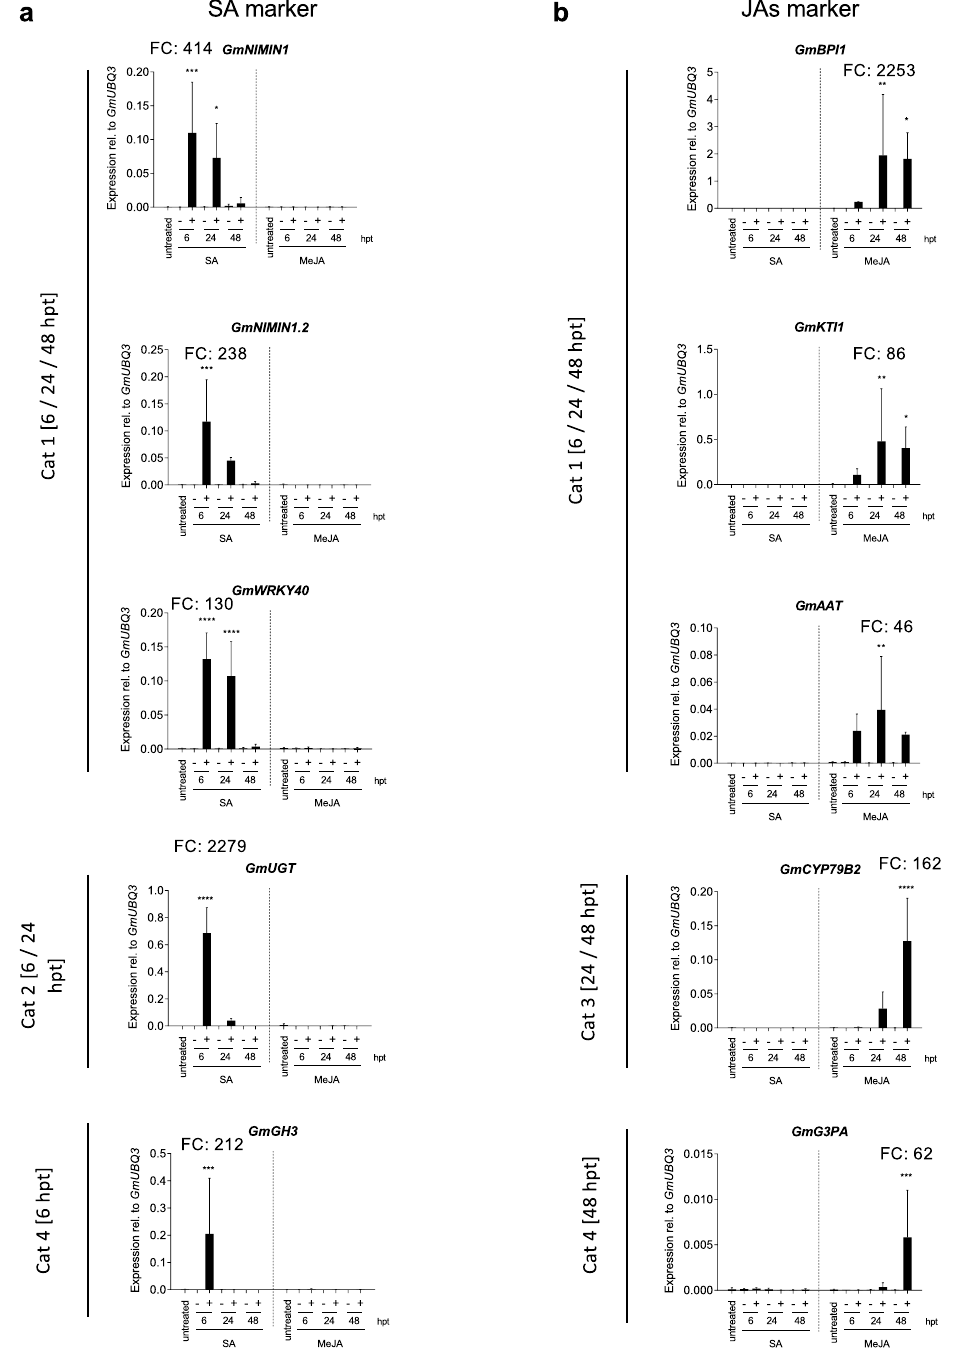
Figure 3. Verification of SA and JAs-induced marker gene expression in soybean leaves. Plants were either left untreated, subjected to control treatment (M) or treated with either SA or MeJA. The expression of selected marker genes was monitored in leaf samples at the indicated times post treatment (hpt) using qRT-PCR analysis. Asterisks indicate significant differences to the untreated control (Dunnett’s multiple comparisons test; *p < 0.05, **p < 0.01, ***p < 0.001, ****p < 0.0001). FC indicates the maximum fold change in gene expression relative to the untreated